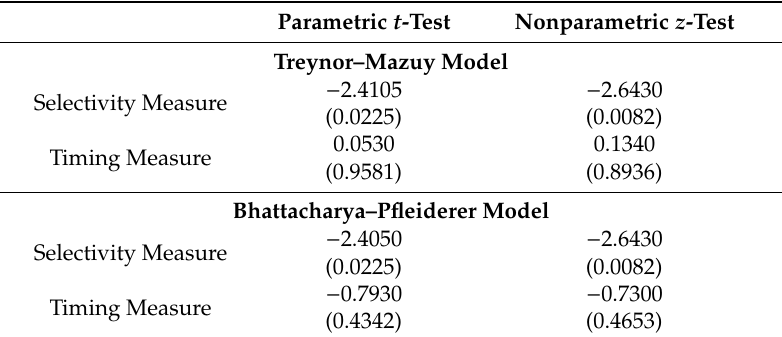
Table 3. Comparative Analysis for Parametric and Nonparametric